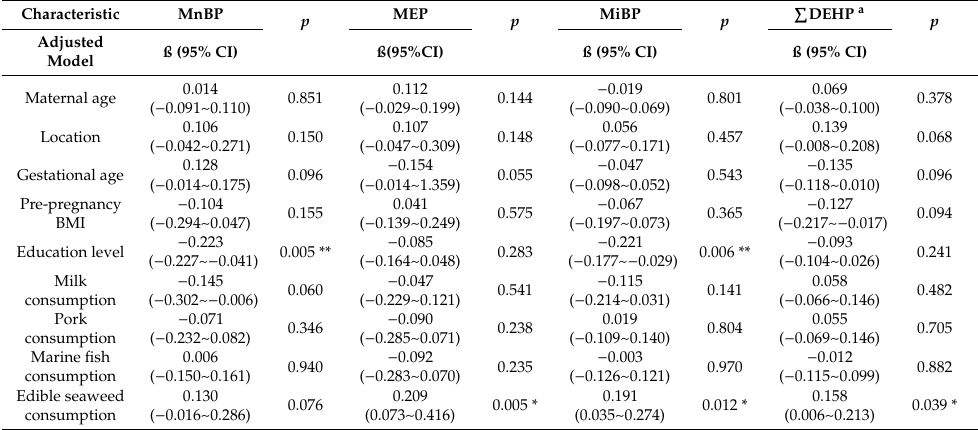
Table 5. Multiple linear regression analysis of certain variables with urinary phthalate metabolite